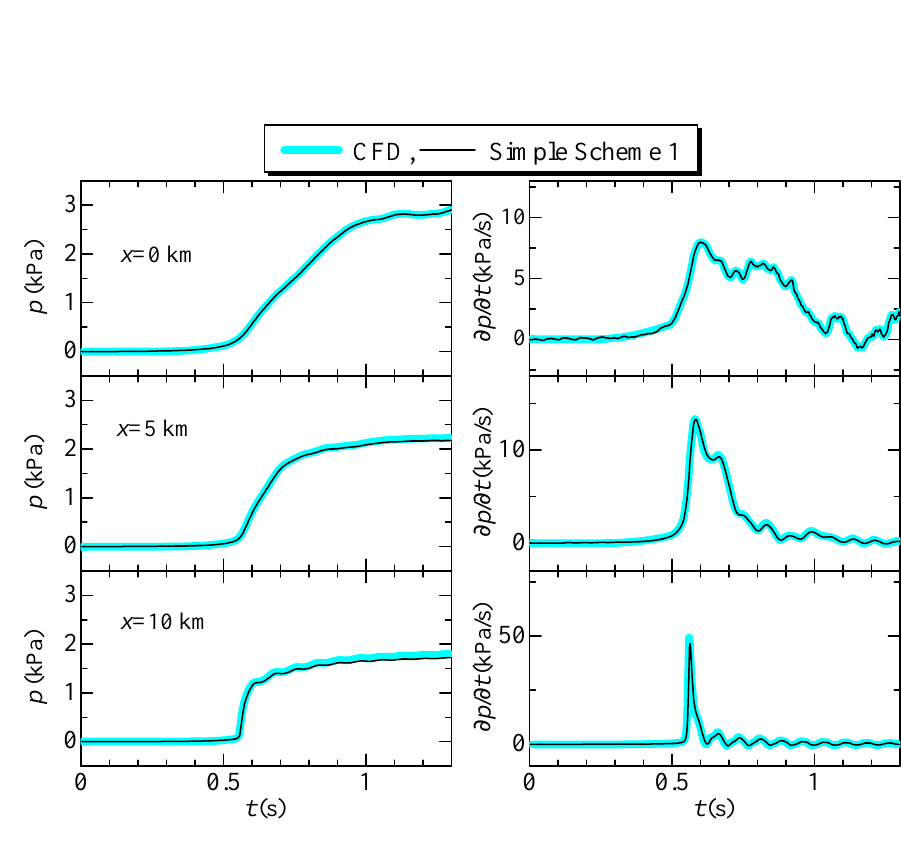
Fig. 5 Comparison of compression waveforms (CASE 1).